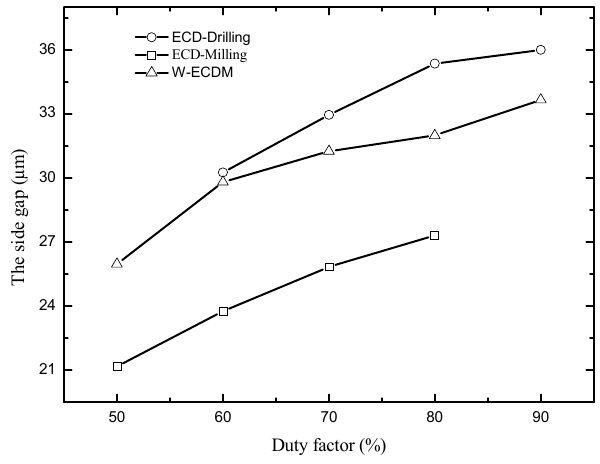
Figure 6. Effect of duty factor on side gap.